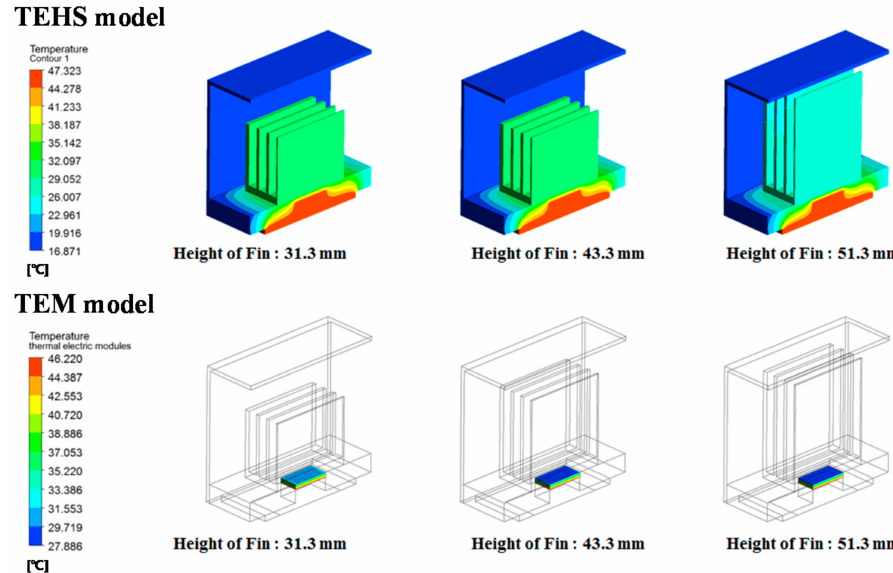
Figure 5. Numerical analysis results of temperature gradient of the TEHS with varying height of cooling fin.